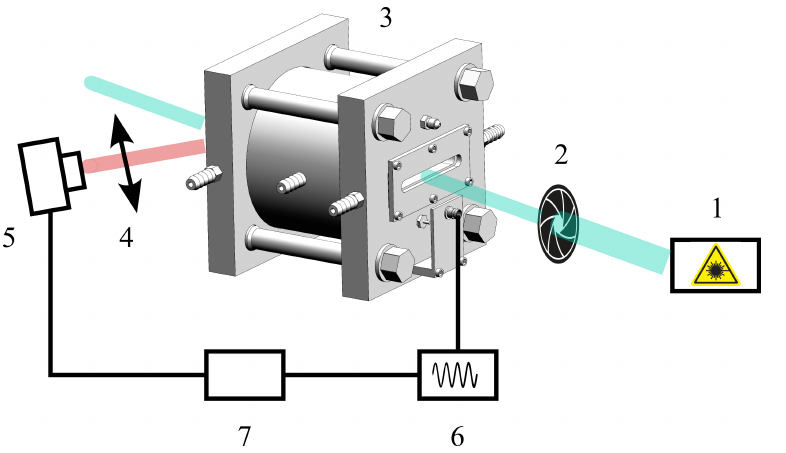
Figure 5. Schematic of experimental setup: 1—radiation source; 2—diaphragm; 3—AO deflector; 4—lens; 5—radiation detector; 6—RF generator; 7—lock-in